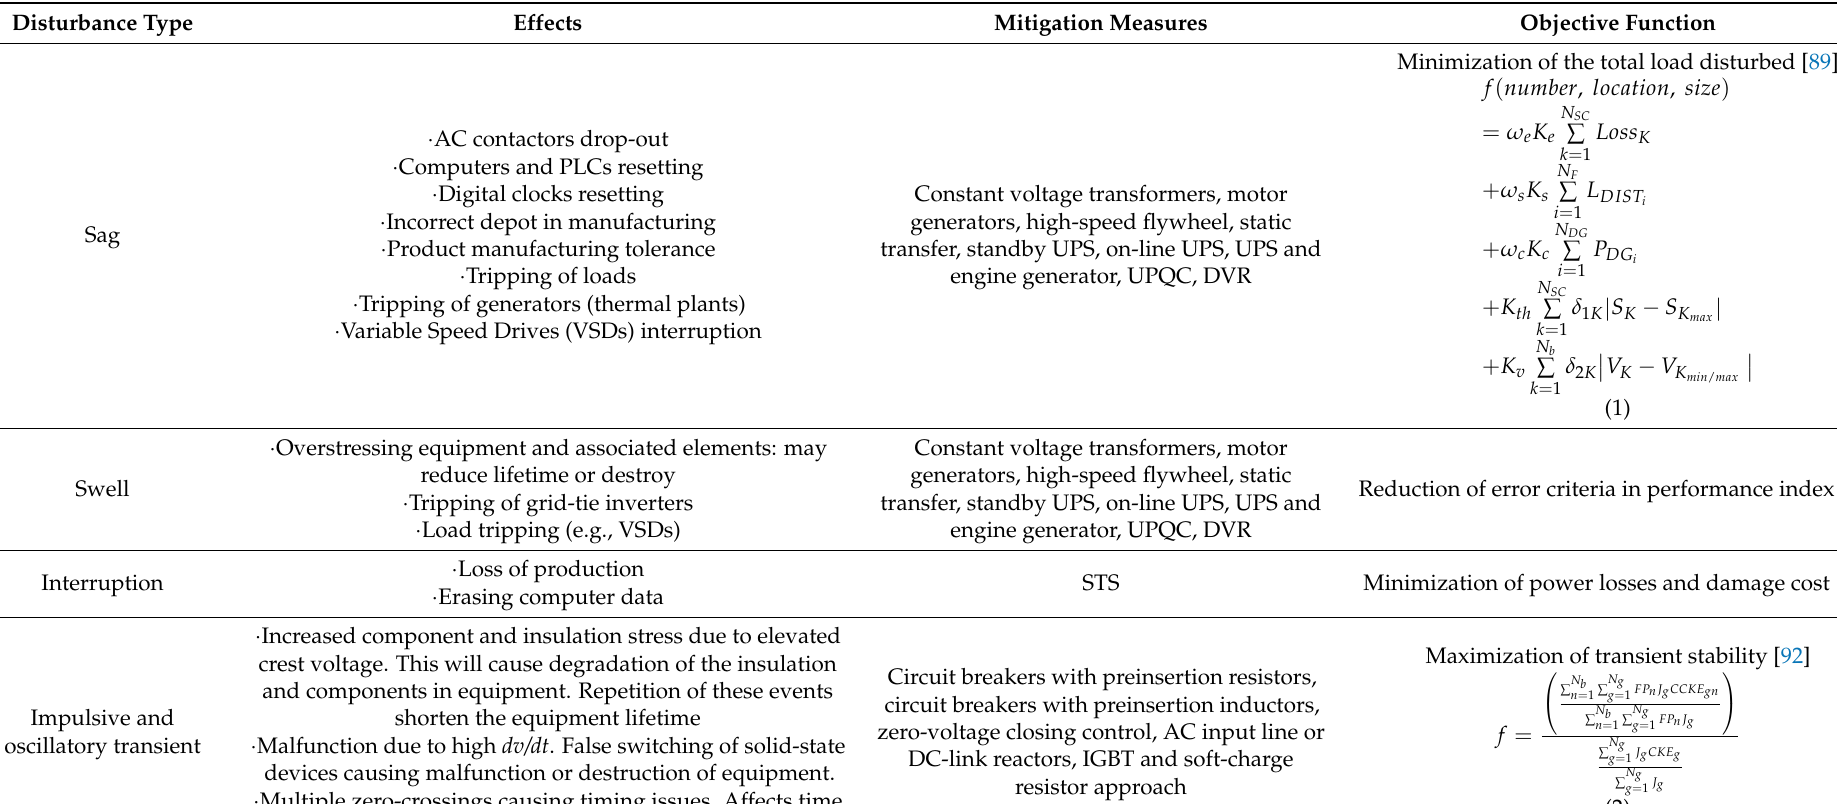
Table 4. Effects, mitigation measures, and objective function for optimization of simple PQ